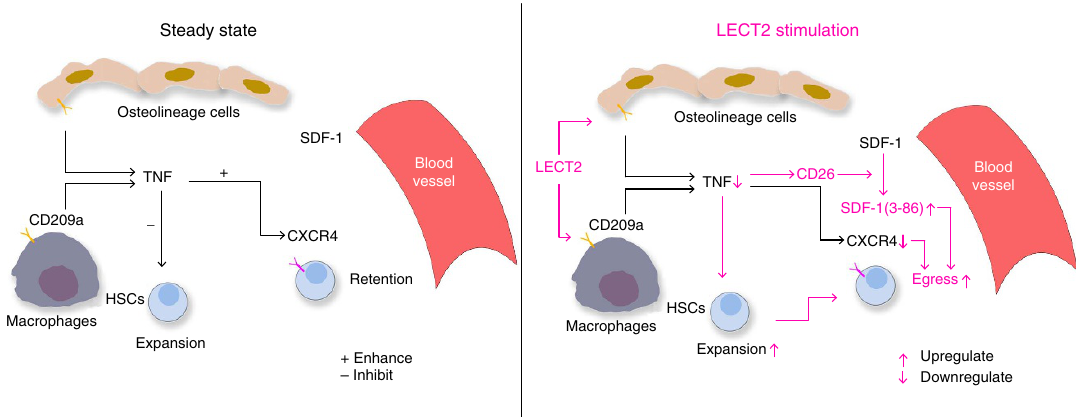
Figure 10 | LECT2 regulates HSC expansion and mobilization. In the steady state, macrophages and osteolineage cells secrete TNF in BM. TNF upregulates CXCR4 expression in HSCs and inhibits the expansion of HSCs. After LECT2 stimulation, TNF secretion from CD209a þ macrophages and osteolineage cells is downregulated in BM. TNF downregulation results in the activation of CD26, which cleaves SDF-1 to SDF-1 (3–86). The SDF-1 (3–86) in BM increases HSC egress to the blood. TNF downregulation also reduces CXCR4 expression in HSCs to enhance HSC egress. Moreover, TNF downregulation causes HSC